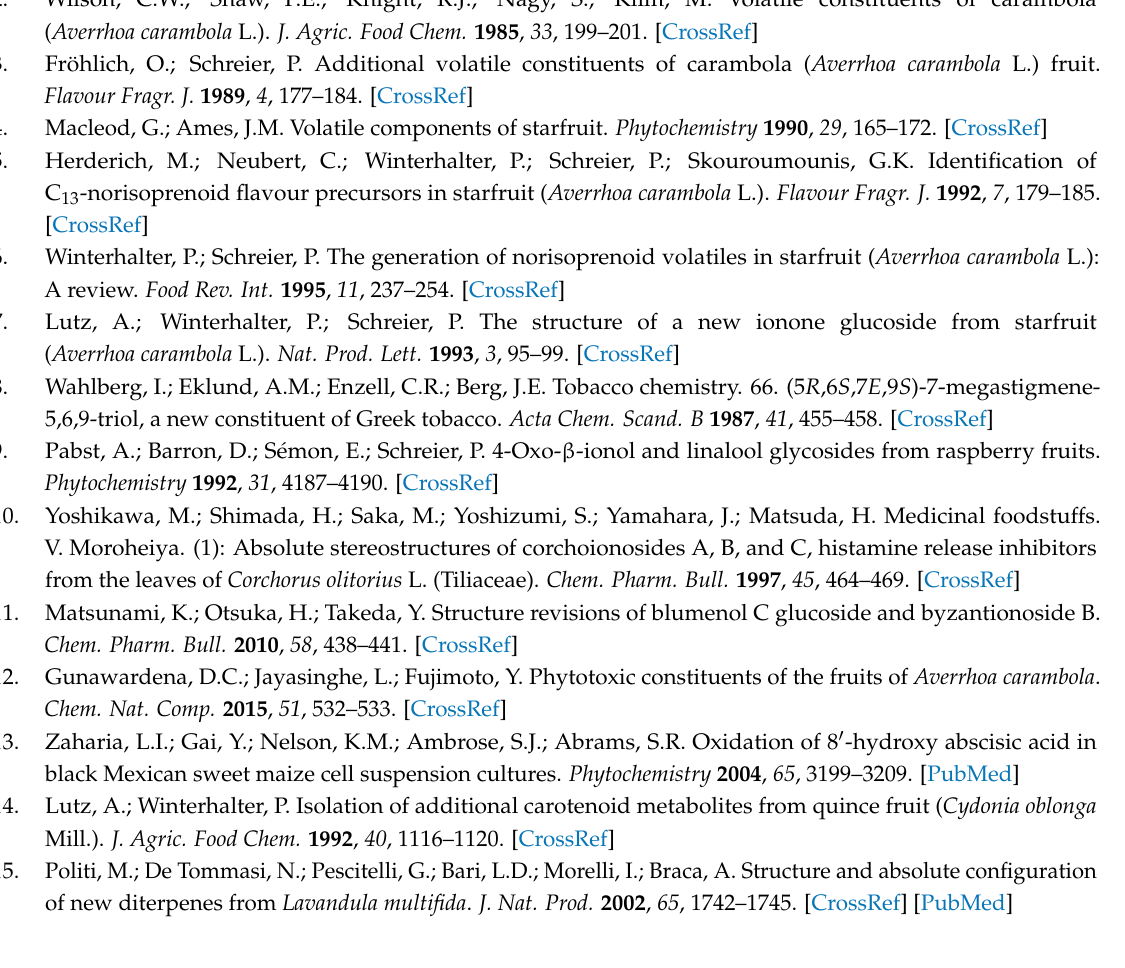
Supplementary Materials: The following are available online. Figures S1–S5: 1D and 2D NMR spectra of compound 1 . Figure S6–S9: 1D and 2D NMR spectra of compound 11 . Spectroscopic data of 14 known